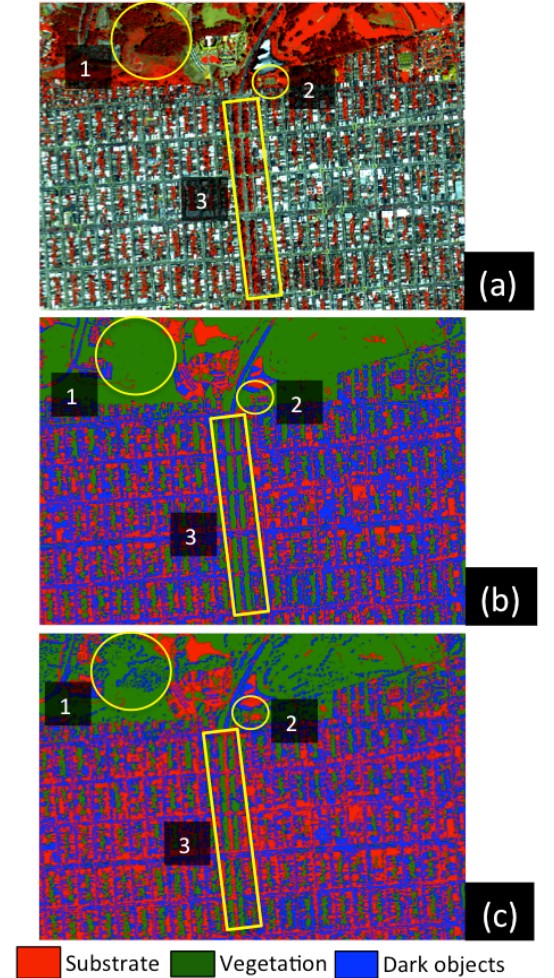
Figure 4: (a) FCC of a downtown area in San Francisco, (b) classified image of the original WV-2 data, (c) classified image of the fused Landsat and WV-2